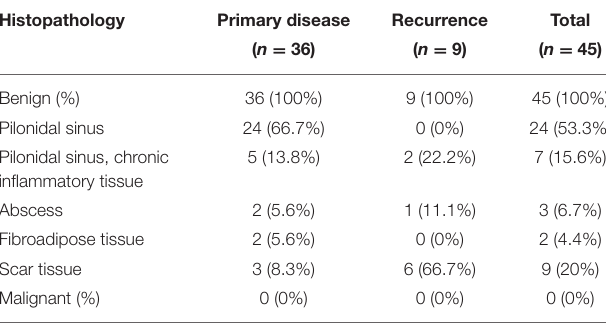
TABLE 2 | Detailed histopathological results of the